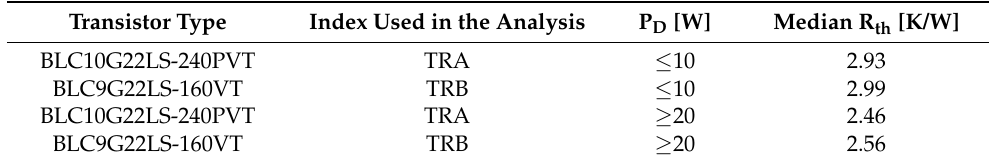
Table 2. Values of the median thermal resistance R th for the tested TRA and TRB transistors with the dissipated power P D ≤ 10 W and P D ≥ 20 W. Transistor